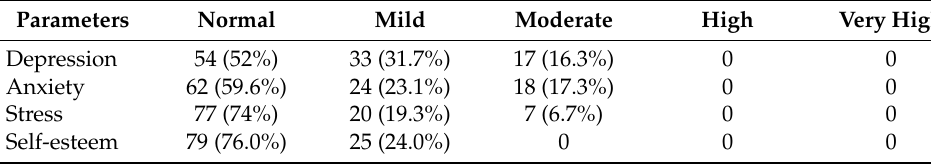
Table 3. Mental health status among the aquaculture